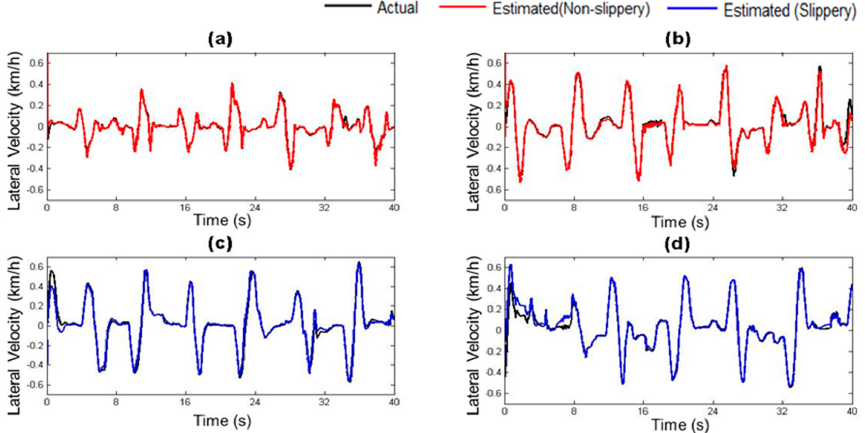
Figure 10. Estimated Lateral Velocity depending on road surface condition: ( a ) Dry asphalt; ( b ) Gravel; ( c ) Wet; and ( d ) Snow.